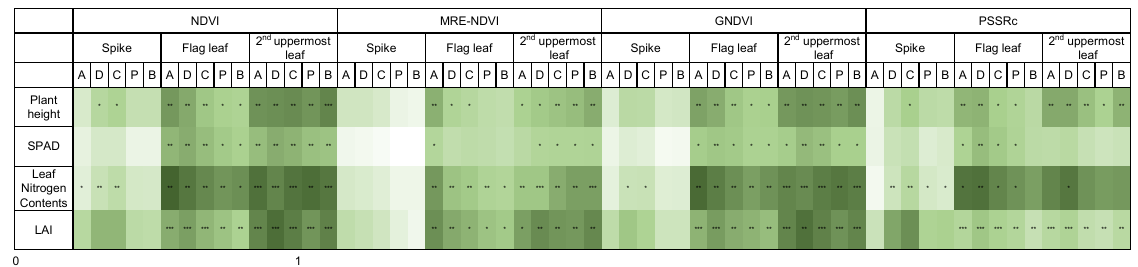
Figure 8. Coefficients of determination by characteristics between vegetation index and SPAD, leaf protein, and leaf area index. A, D, C, P, and B indicate apex, distal, central, proximal, and base, respectively. *, **, and *** mean significant at 0.05, 0.01, 0.001 probability level.